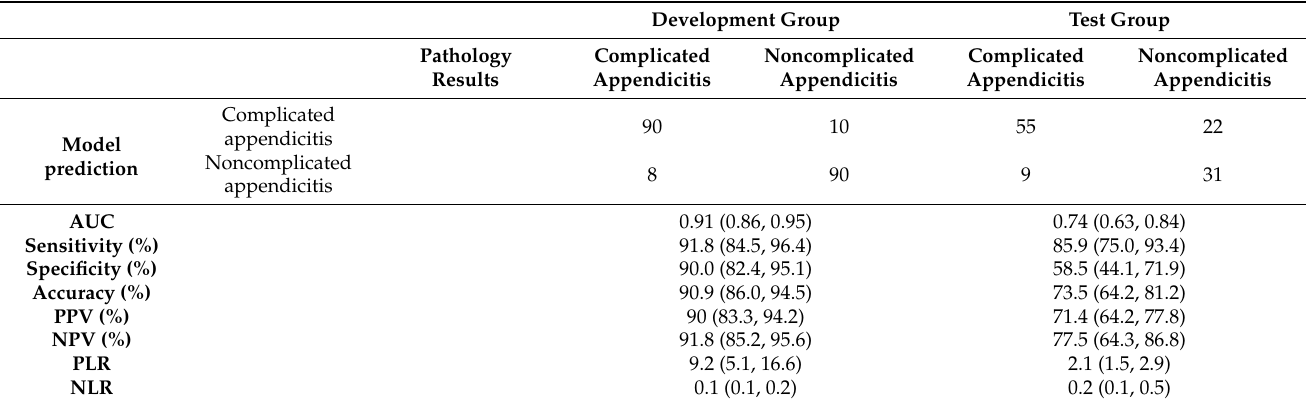
Table 3. Diagnostic performance of decision tree algorithm for diagnosing complicated acute ap- pendicitis.